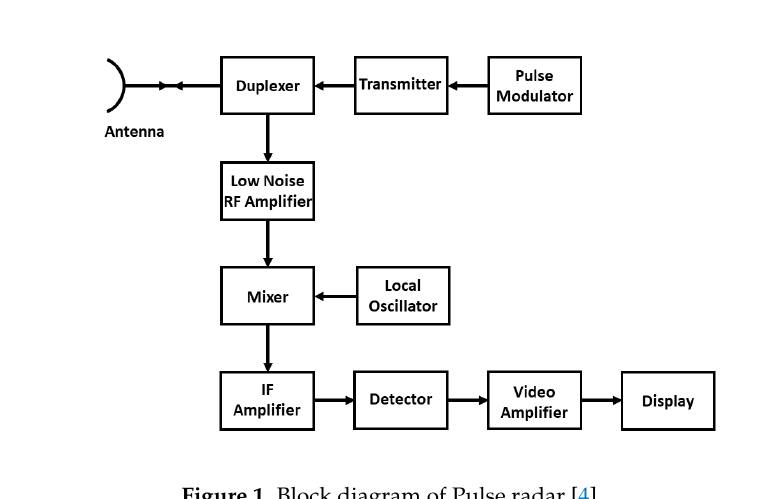
Figure 1. Block diagram of Pulse radar [4].